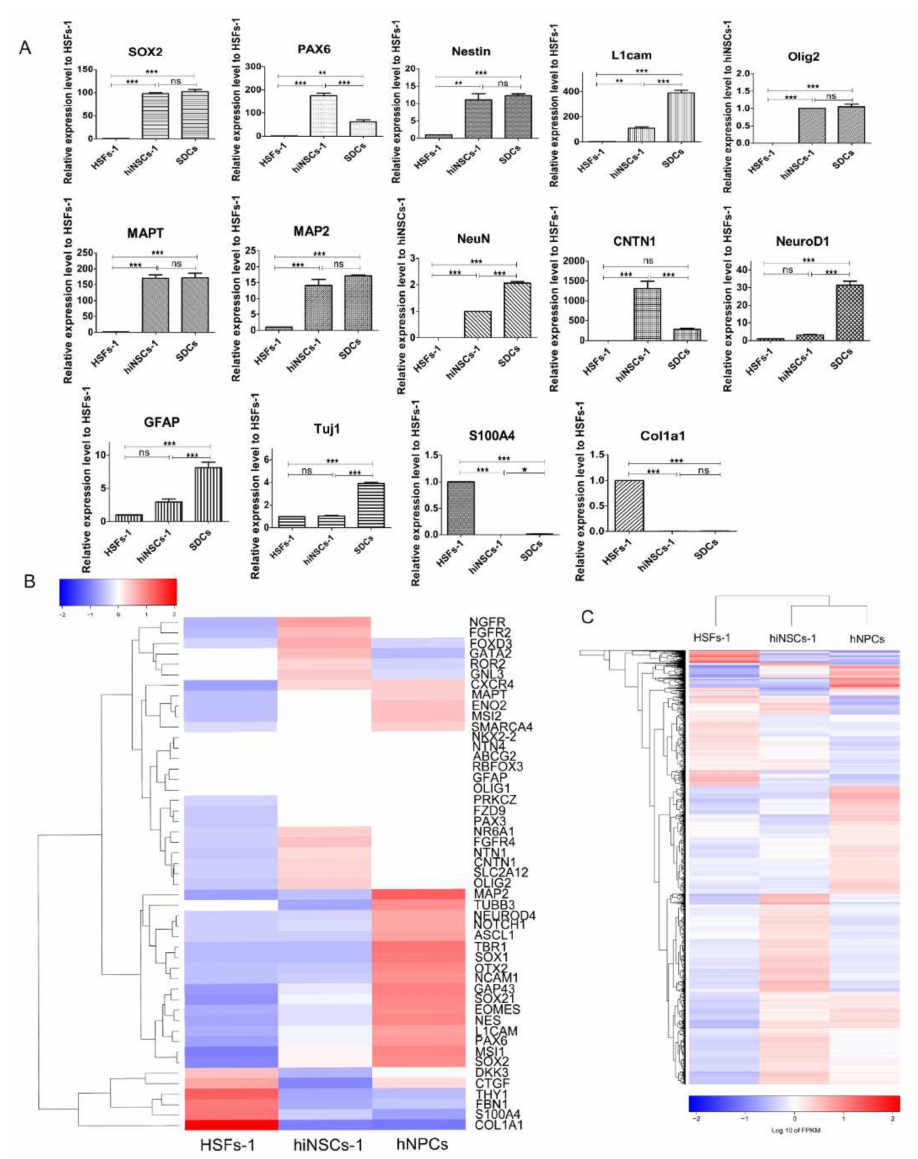
Figure 2. hiNSCs-1 express multiple up-regulated NSCs makers and down-regulated fibroblast- specific genes. ( A ) qRT-PCR results of the expression of some neural-lineage makers and fibroblast- specific genes in HSFs-1, hiNSCs-1 and spontaneous differentiated cells (SDCs). * p < 0.05, ** p < 0.01, *** p < 0.001, ns = not significant. ( B ) Heatmap of the expression of neural lineage makers and fibroblast-specific genes in HSFs-1, hiNSCs-1, and hNPCs using RNA-sequencing. ( C ) Heatmap and hierarchical clustering of genes with significance in HSFs-1, hiNSCs-1, and hNPCs using